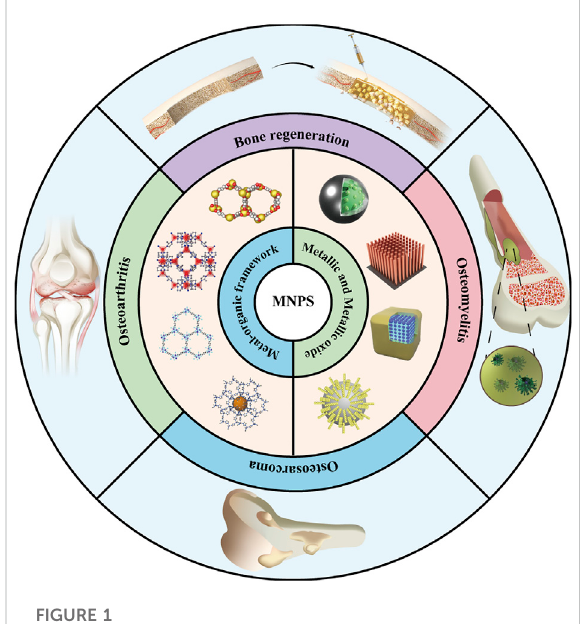
FIGURE 1 Application of metal-based nano-delivery platform for treating bone disease and